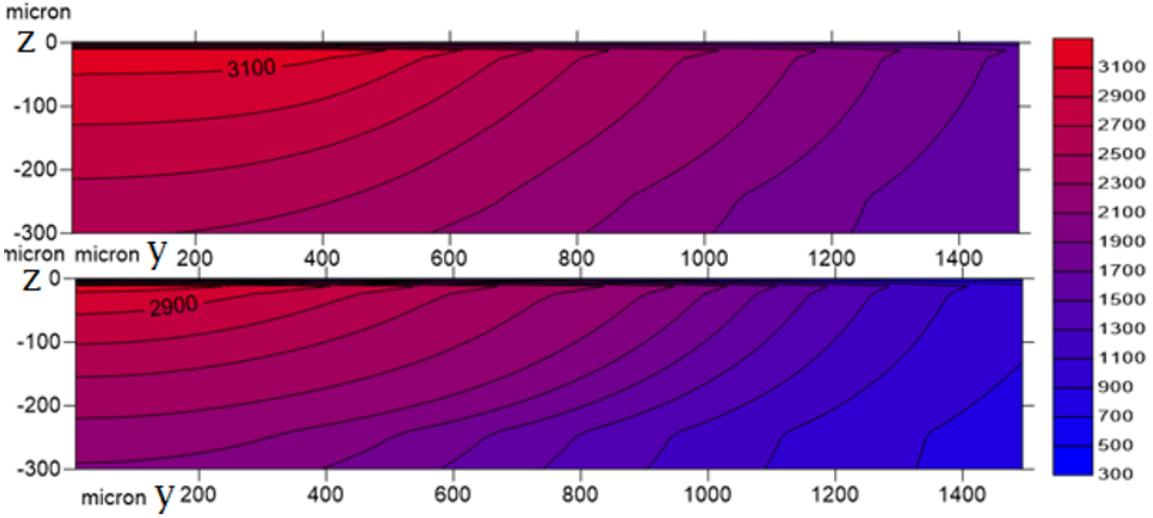
Fig. 4. Distribution of the maximum temperature (K) attained in the transversal cross section (YZ) for the modeled processes of laser melting of glass. On the top, processes modeled with ambient temperature = 1100 K. Below, ambient temperature = 300